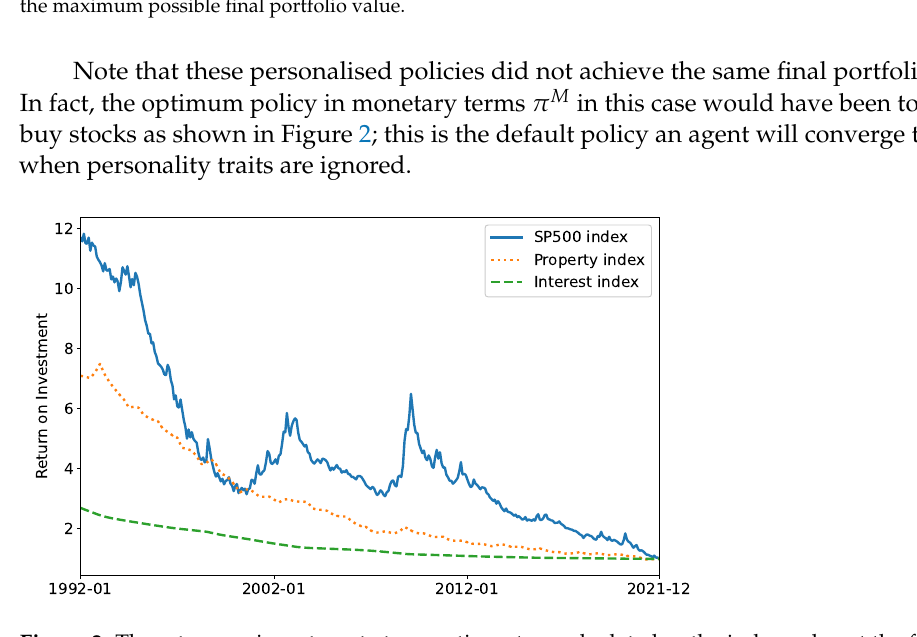
Figure 2. The return on investment at every time step, calculated as the index value at the final time step divided by the index value at the current time step. It is clear that S&P 500 has the greatest return on investment at every time step, except for a brief period in ca. 2000 where it was marginally below the property index. Therefore, the optimum monetary policy π M is to always invest the maximum amount into